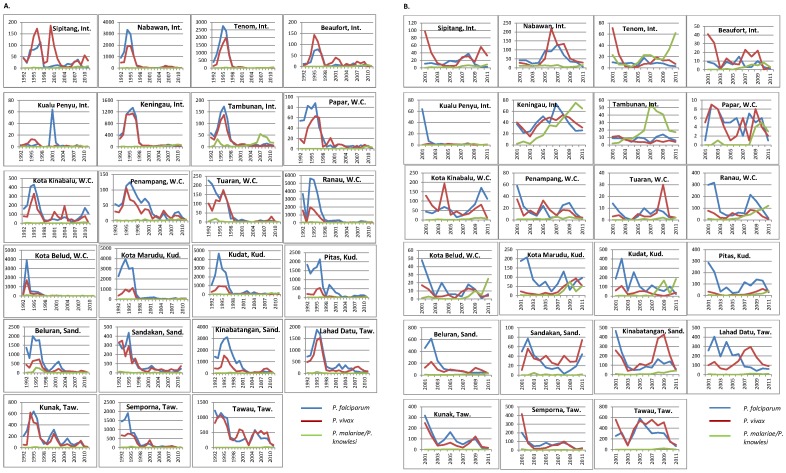
Malaria notifications by district.
A. Malaria notifications by district 1992–2011; B. Malaria notifications by district 2001–2011. Int.: Interior Division; W.C.: West Coast Division; Kud.: Kudat Division; Sand.: Sandakan Division; Taw.: Tawau Division.